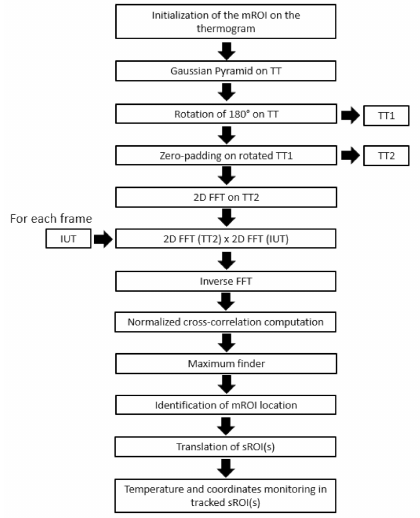
Figure 3. Flow chart for the tracking